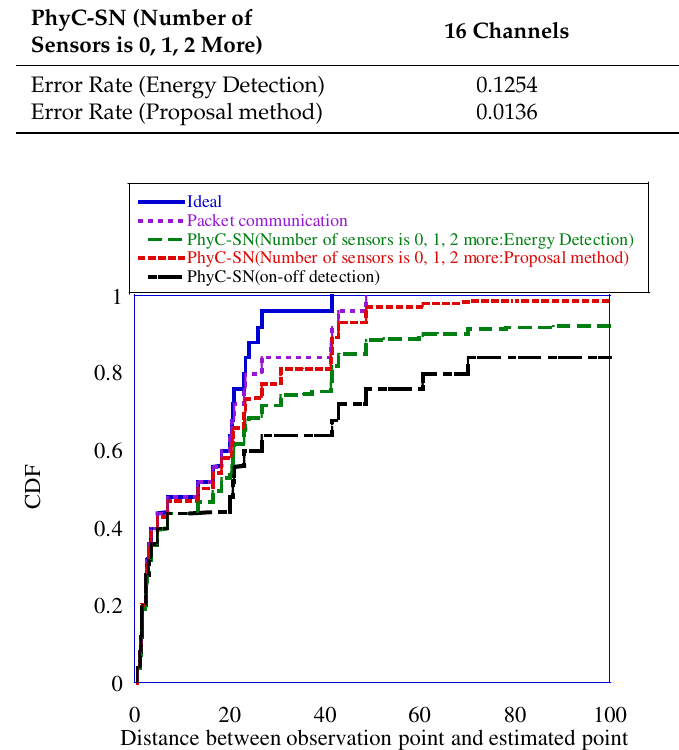
Figure 17. Positioning error at 16